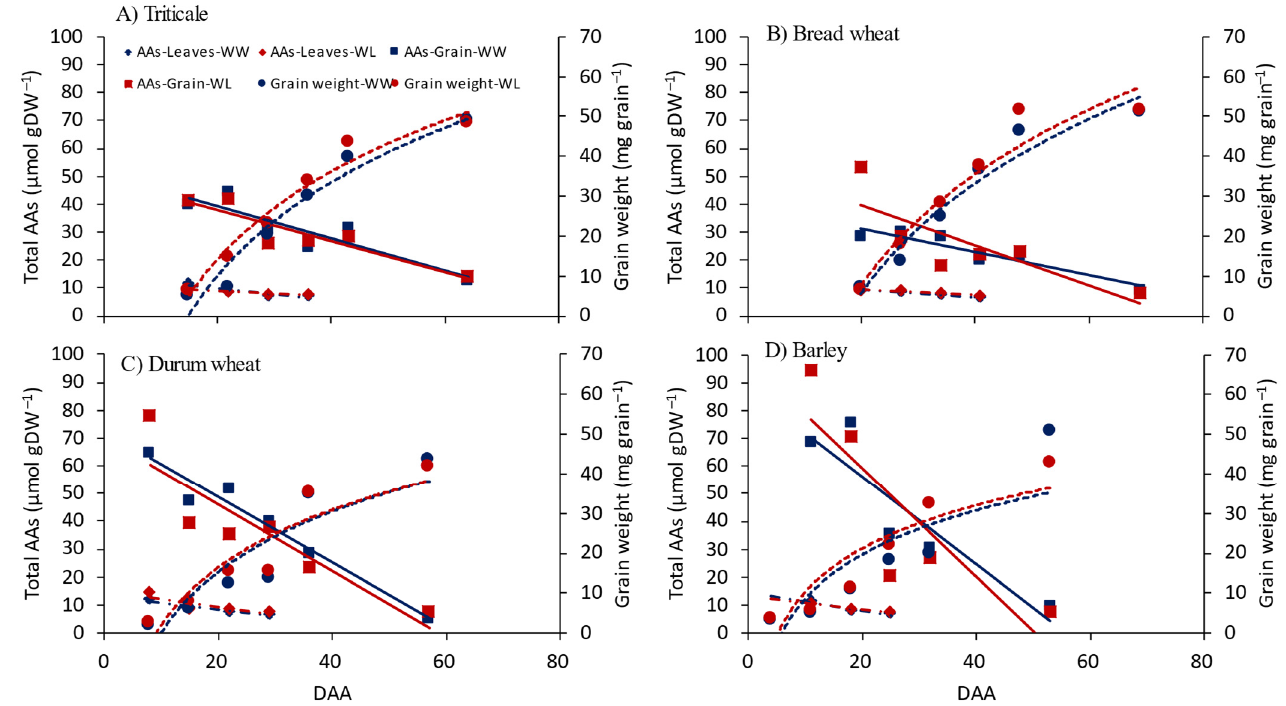
Figure 7. Time variation (expressed as days after anthesis, DAA) of the total amino acid concentration in leaves (diamonds) and in grain (square), and grain weight (circle), in the four cereals ( A ) triticale, ( B ) bread wheat, ( C ) durum wheat, and ( D ) barley grown under well-watered (blue) and water-limited (red) regimes. The regression equations are in Table S6.